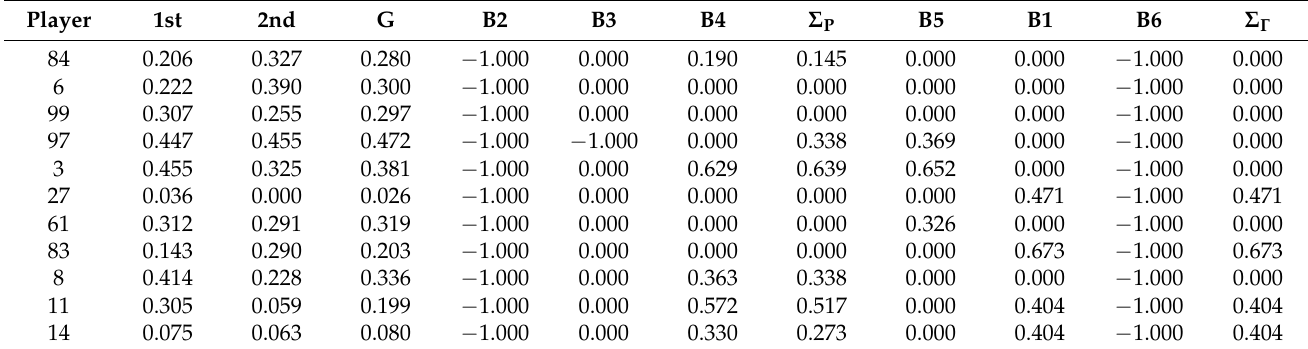
Table A9. Team A’s Eigenvector Centrality Matrix of values.